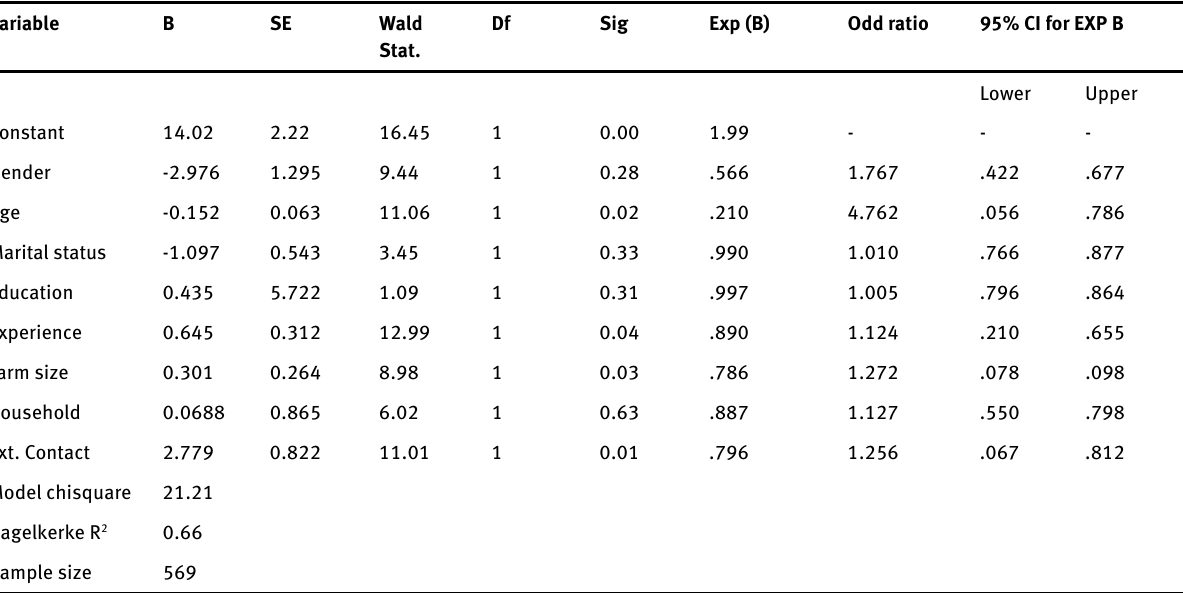
Table 10: Logit Regression Showing relationship between socio-economic variables and practice of disease control